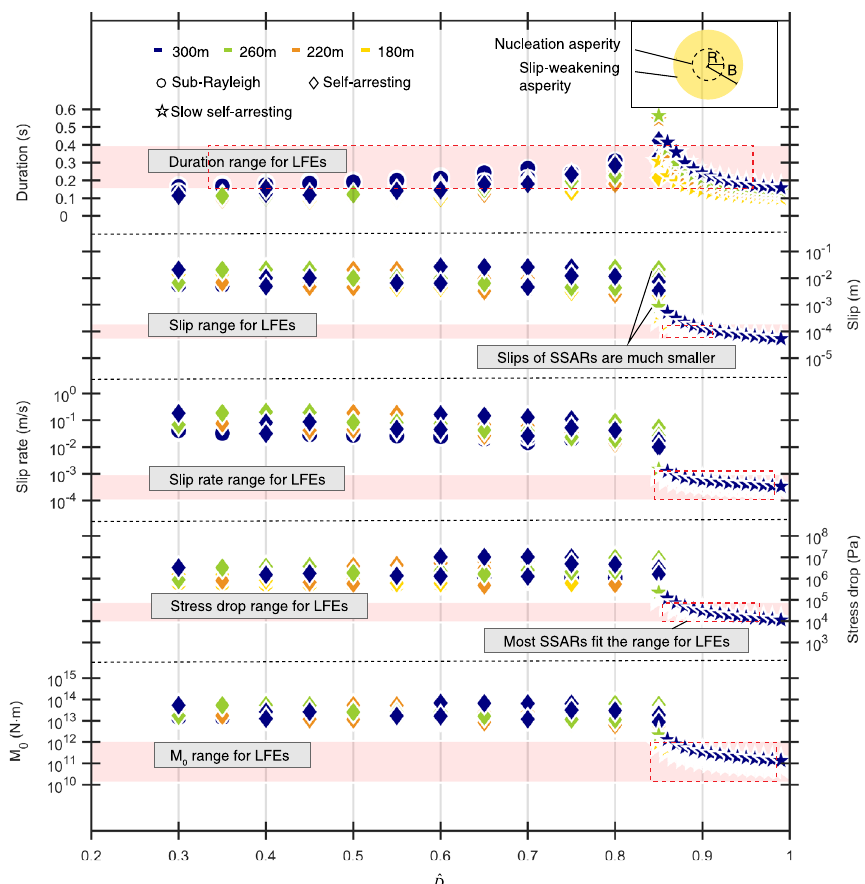
Fig. 3 Source characteristics comparison between simulated ruptures and LFEs in Park fi eld. The duration, slip, slip rate, stress drop and seismic moment magnitudes are compared. Pink strips denote the estimated source parameters ranges for LFEs in Park fi eld, and colored dots show the results of numerical simulated earthquakes. Different dot colors represent different simulated rupture patch diameters, while different dot shapes show different types of ruptures in simulations. The blue, green, orange, and yellow dots denote simulated earthquakes with rupture diameter 300 m, 260 m, 220m, and 180 m, respectively. The circles, diamonds and stars denote the sub-Rayleigh earthquakes, self-arresting earthquakes, and slow self-arresting earthquakes, respectively. In addition, the red dashed rectangles show the ranges where the source parameters of simulated earthquakes match those of